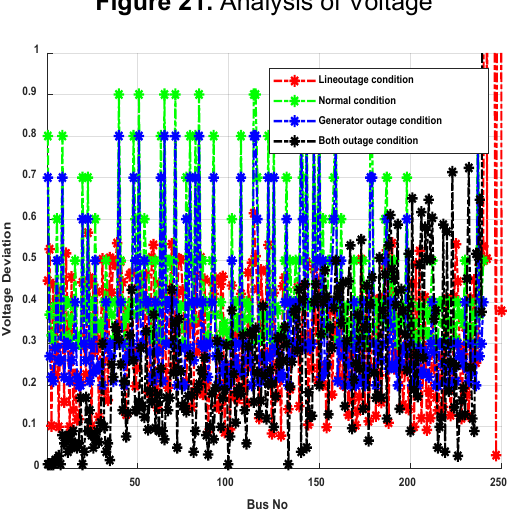
Figure 21. Analysis of Voltage